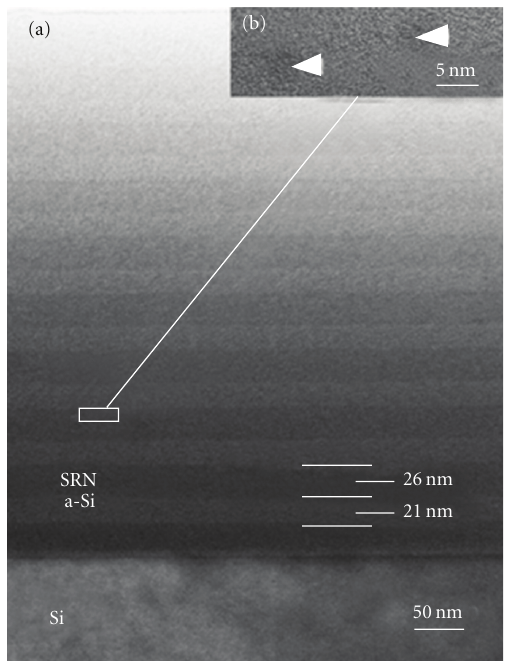
Figure 1: (a) Cross-sectional TEM bright-field micrograph of Si- rich nitride/amorphous-Si superlattice structure consisting of 10 SRN layers and 9 a-Si layers for a total thickness of 450 nm. (b) Higher magnification of a SRN layer, showing amorphous Si nano- crystals (approximately 2nm in diameter) marked by